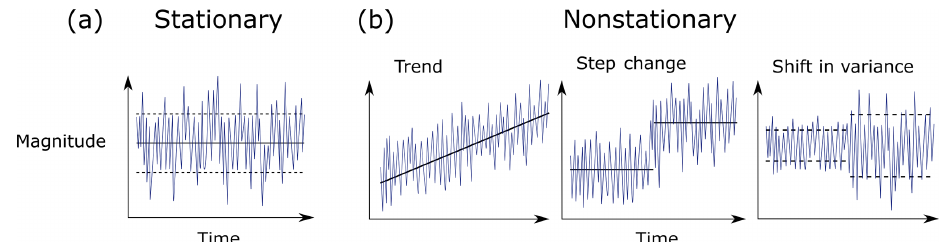
Figure 1. What is nonstationarity? Examples of (a) a stationary time series with constant mean and variance and (b) three nonstationary time series in the form of a shift in mean (trend and step change) and a shift in variance. Solid and dashed black lines represent the mean and the variance of the time series,